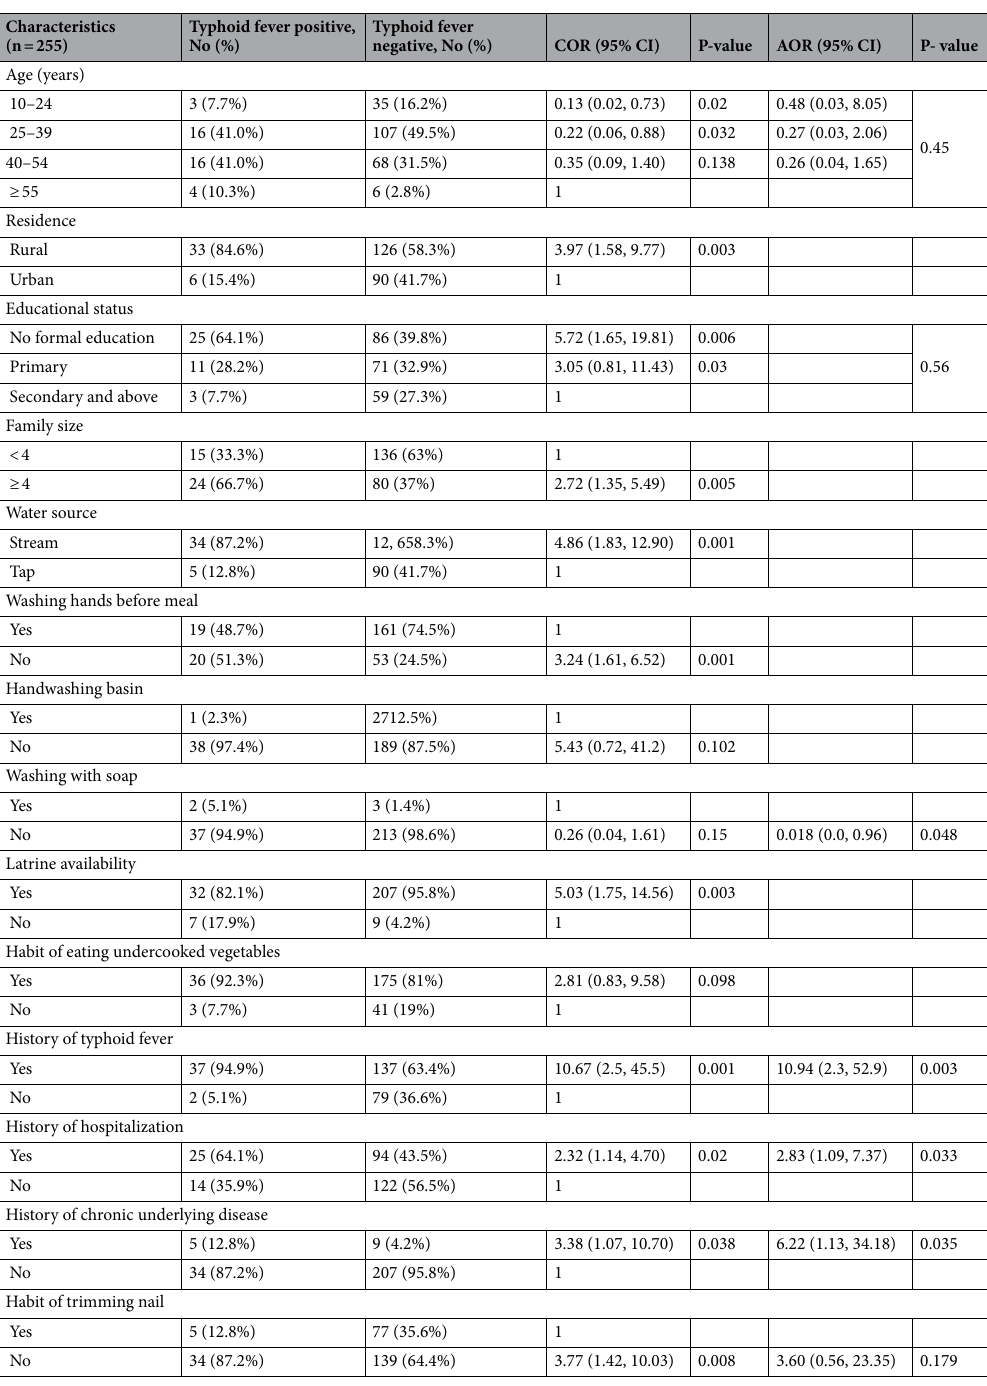
Table 2. Bivariate and multivariable analysis of socio-demographic and clinical variables of typhoid fever suspected patients at Gaint and Meket Shediho primary hospitals, Ethiopia, 2021. No number, COR crude odds ratio, AOR adjusted odds